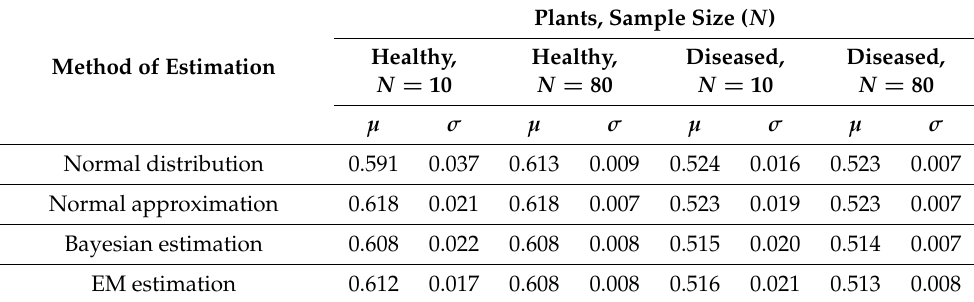
Table 8. Mean value of the relative error ( % ) for the five days of the experiment per method of estimation and per sample size, N , for Healthy and Diseased plants of the bacteria data set. Plants, Sample Size ( N ) Method of Estimation Healthy, Healthy, Diseased, Diseased, N = 10 N = 80 N = 10 N = 80 Normal distribution 2 1 6 6 Normal approximation 2 2 6 6 Bayesian estimation 0 0 4 4 EM estimation 1